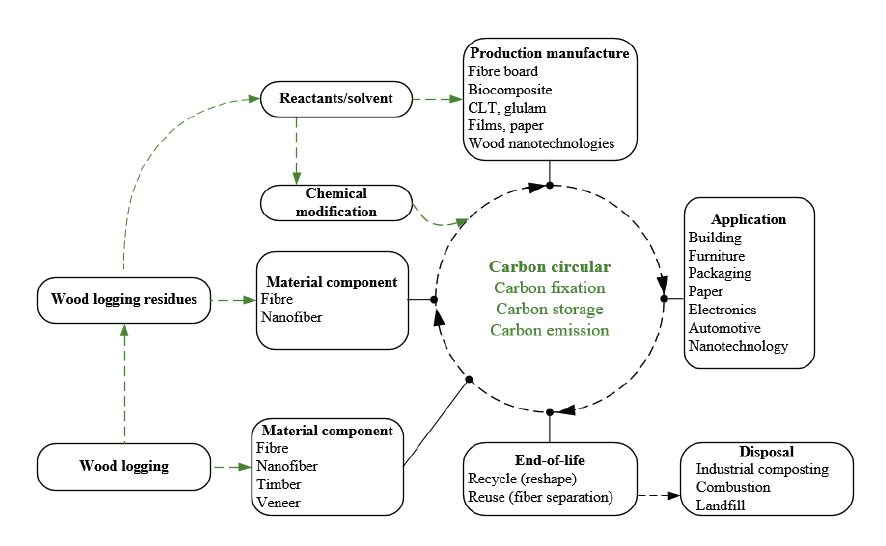
Fig 1. The sustainable carbon cycle of wood logging residues